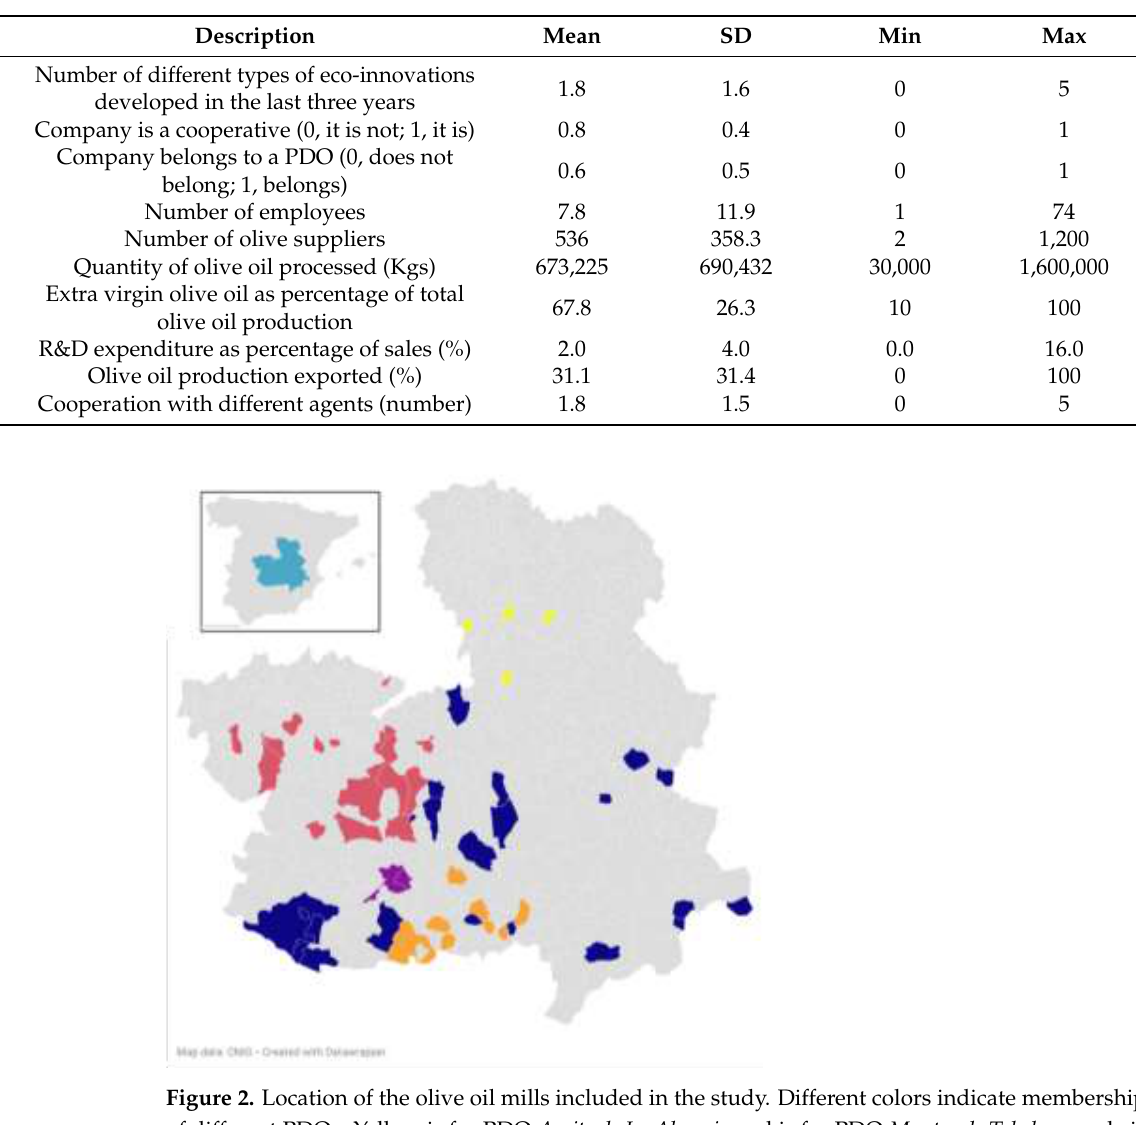
Table 1. Definition of variables and descriptive statistics.